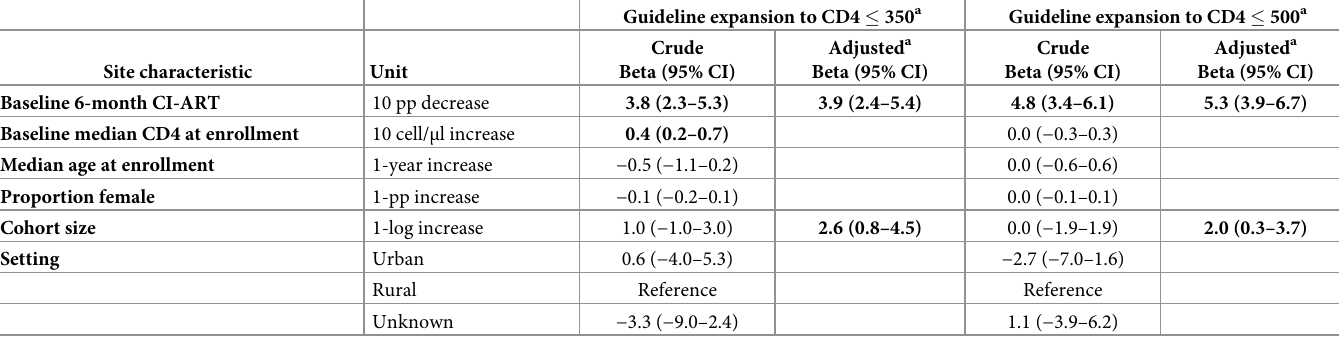
Table 3. Crude and adjusted metaregression analyses of change in 6-month cumulative incidence of antiretroviral treatment initiation (CI-ART) after ART eligibil- ity guideline expansion to CD4 (cid:20) 350 and CD4 (cid:20) 500. Guideline expansion to CD4 (cid:20) 350